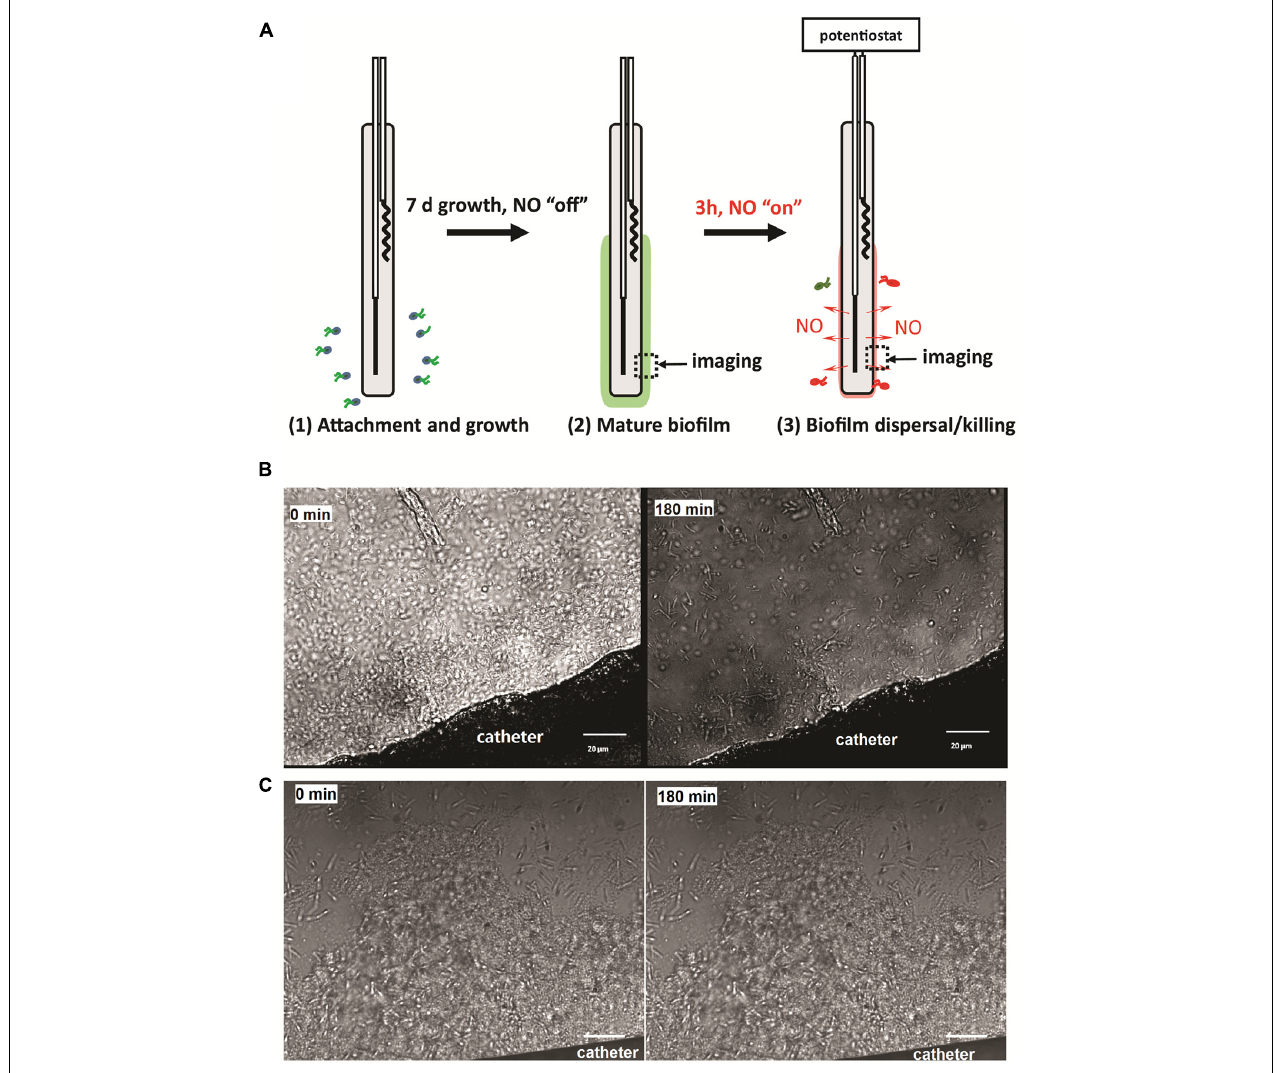
FIGURE 2 | (A) Illustration of the experimental procedure used in this study; (B) representative images of NO release catheter surface and its biofilm at 0 and 3 h. NO release from the surfaces of the catheters at a flux of 1.5 × 10 − 10 mol cm − 2 min − 1 ; (C) representative images of biofilm on control catheters at 0 and 3 h. Green dash line indicates the edge of biofilm. Black arrow shows the location of